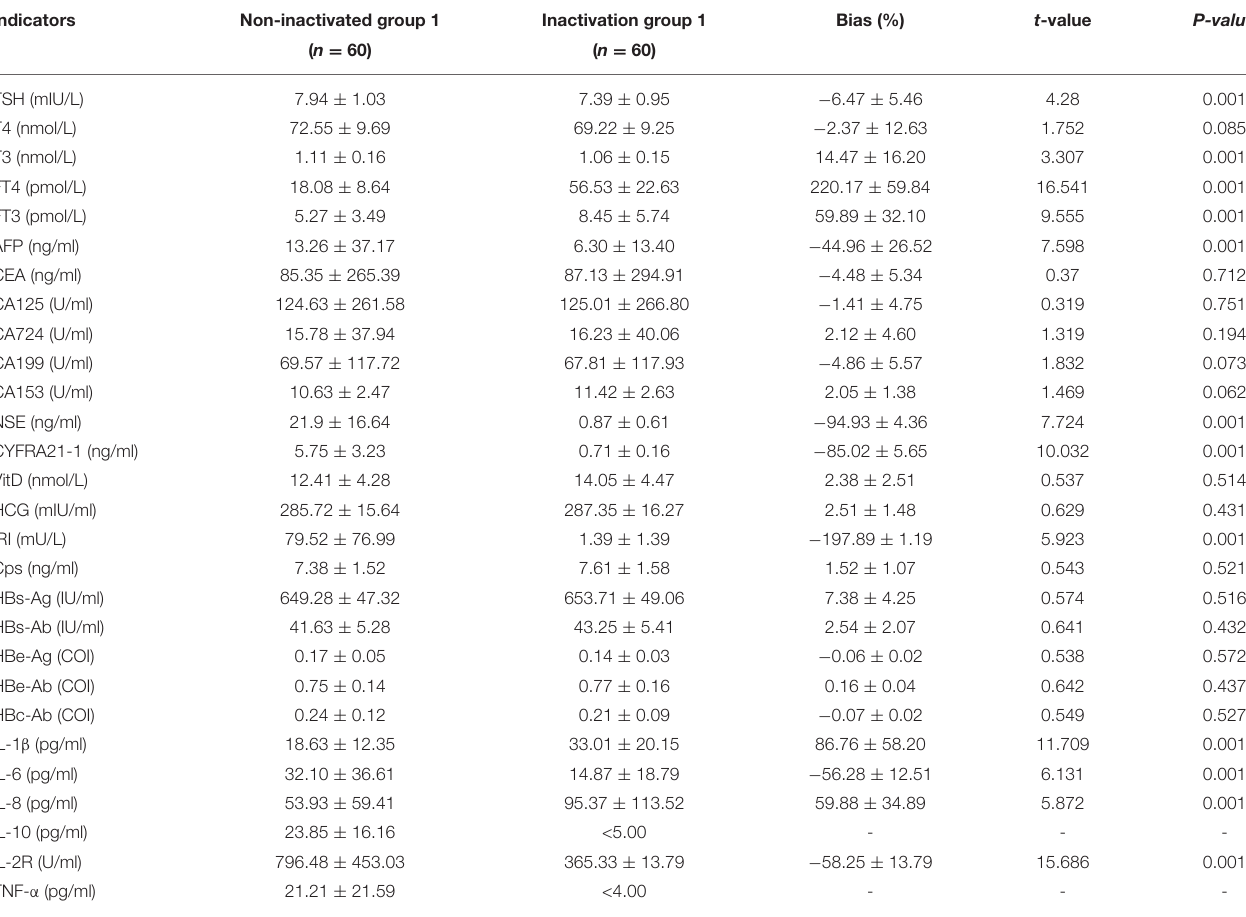
TABLE 2 | Comparison of the test results of the two groups before and after heat inactivation.